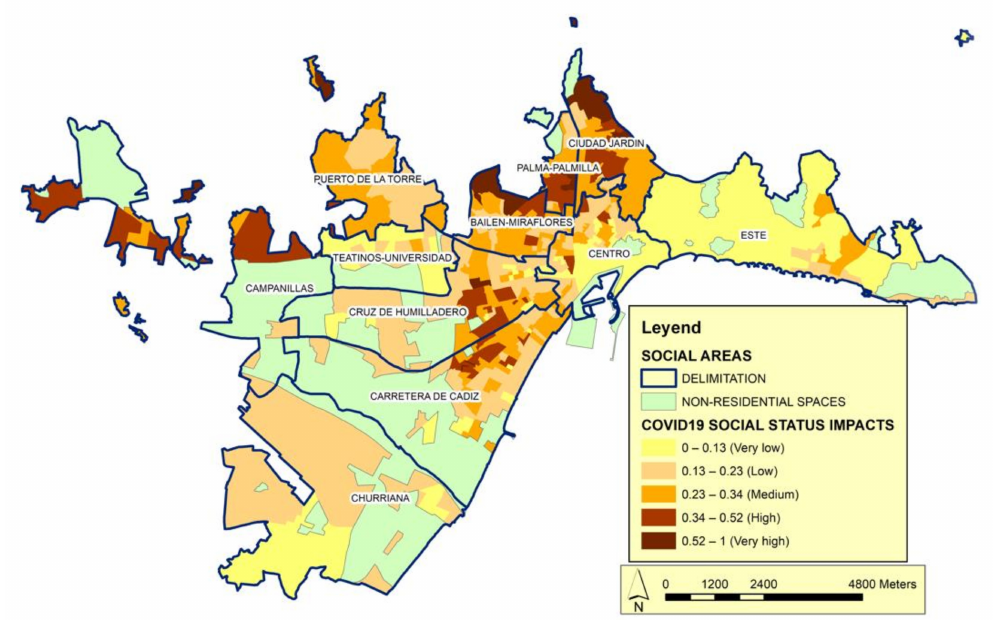
Figure 6. Distribution of the impact of COVID-19 according to the Social Status category. Source: Author’s elaboration. The impact index shows the correlation between Social Status vulnerability calculated according to the variables of this category in relation to the number of cases.